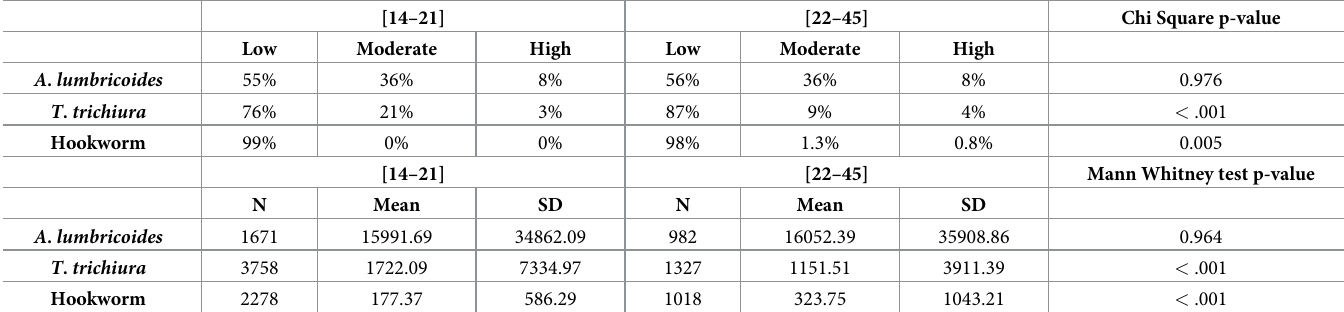
Table 7. Infection intensities per species between type of follow-up.